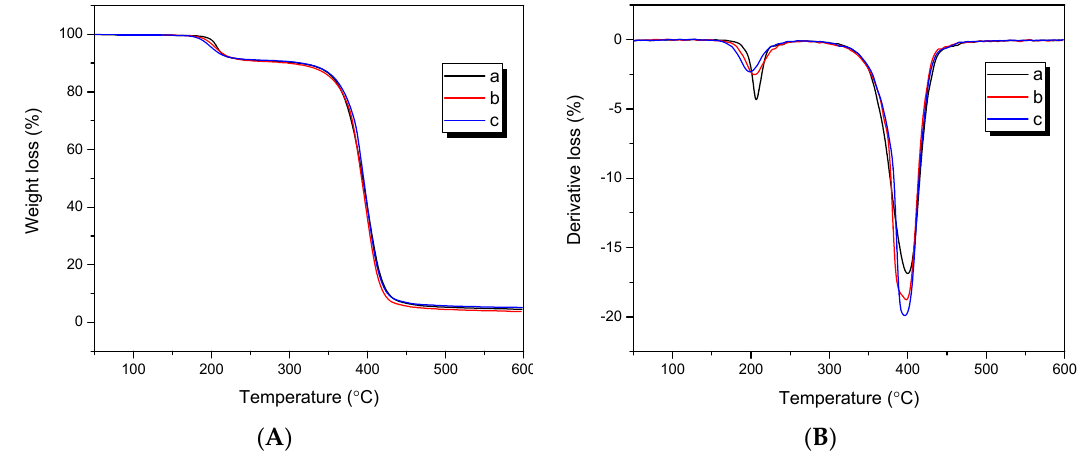
Figure 8. TGA ( A ) and DTG ( B ) curves of the low gloss acrylic polymer films with crosslinker AMA contents ranging from (a) 0 wt % to (b) 0.2 wt % and to (c) 0.4 wt %, respectively. Table 2. Comprehensive properties of the acrylic resin with crosslinker AMA contents ranging from 0 wt % (a) to 0.2 wt % (b) and to 0.4 wt % (c),